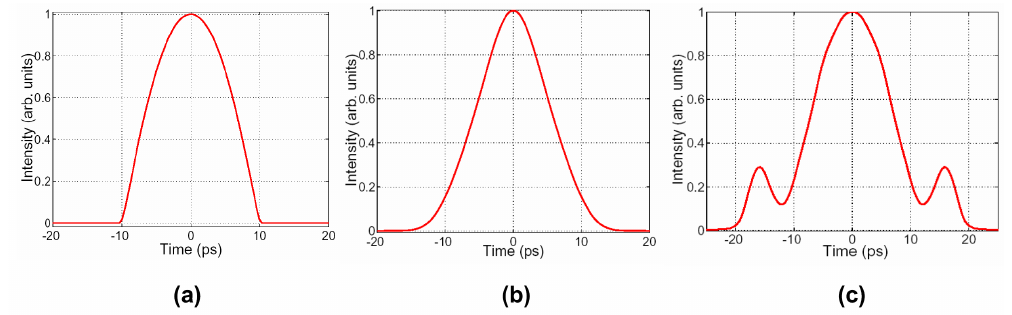
Figure 3. Intensity pulse shaping profiles generated from the proposed mode-locked laser design with the interactivity pulse shaper. ( a ) No pulse shaping enabled (parabolic intensity profile). ( b ) Pulse shaping enabled with the following 32-bit code word: 10110000000000111100000000001101. ( c ) Pulse shaping enabled with the following 32-bit code word: 11111001001111111111001110011111.